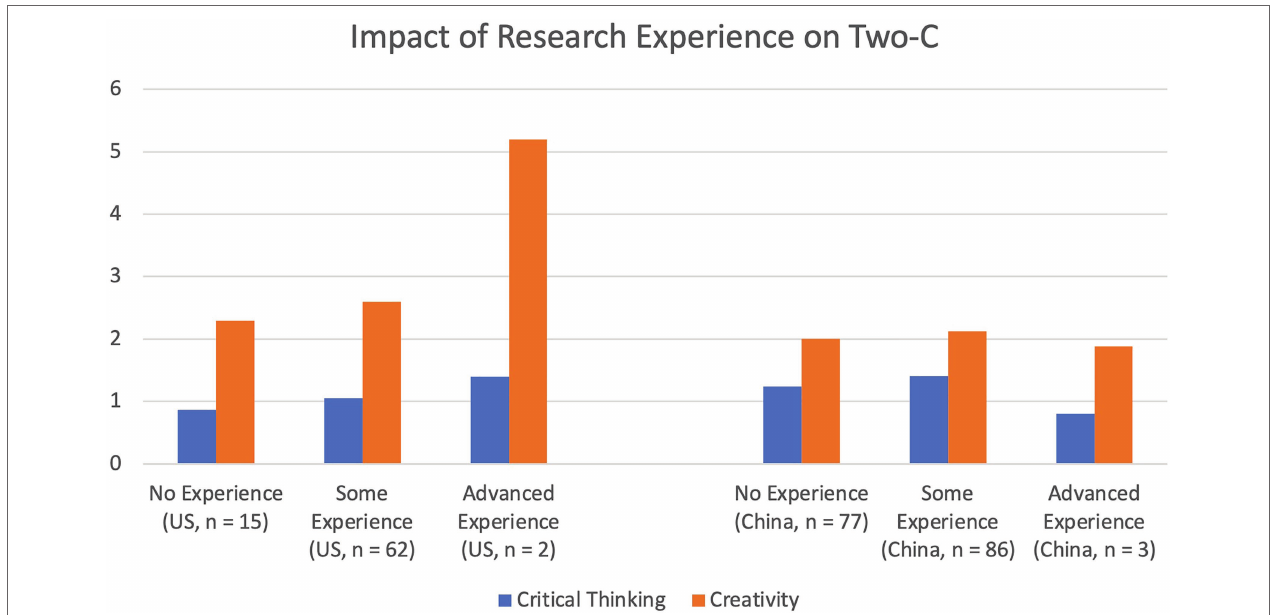
FIGURE 2 | Estimated marginal means of Two-C for the United States and Chinese